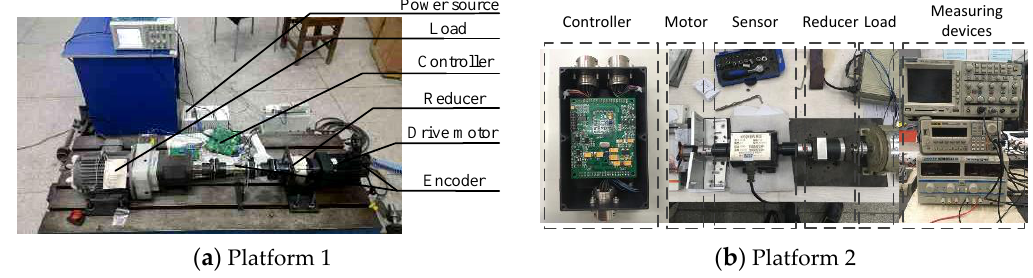
Figure 3. Platform of the experimental system.